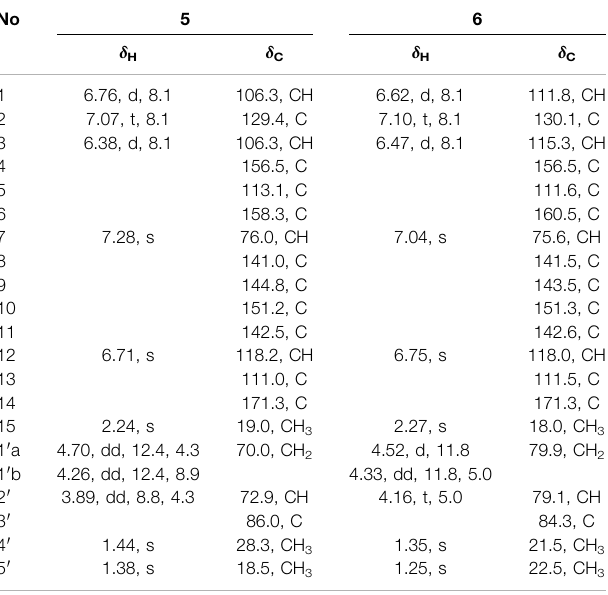
TABLE 3 | 1 H (600 MHz) and 13 C (150 MHz) NMR data of 5 and 6 in CD 3 COCD 3 .